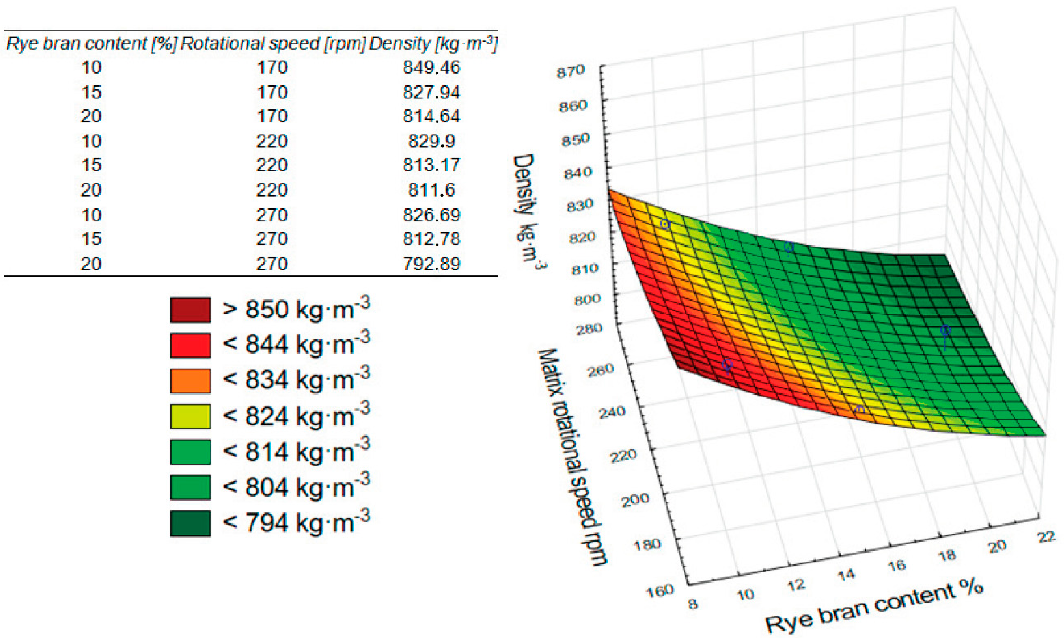
Figure 3. The impact of rye bran content and rotational speed of the matrix on the density of pellets.